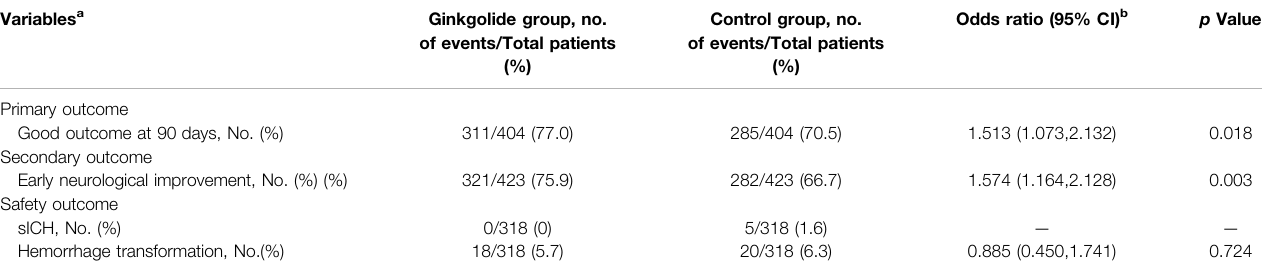
TABLE 3 | Neurological Outcome and Complication Among matched cohorts between two groups after conditional logistic regression. Variables a